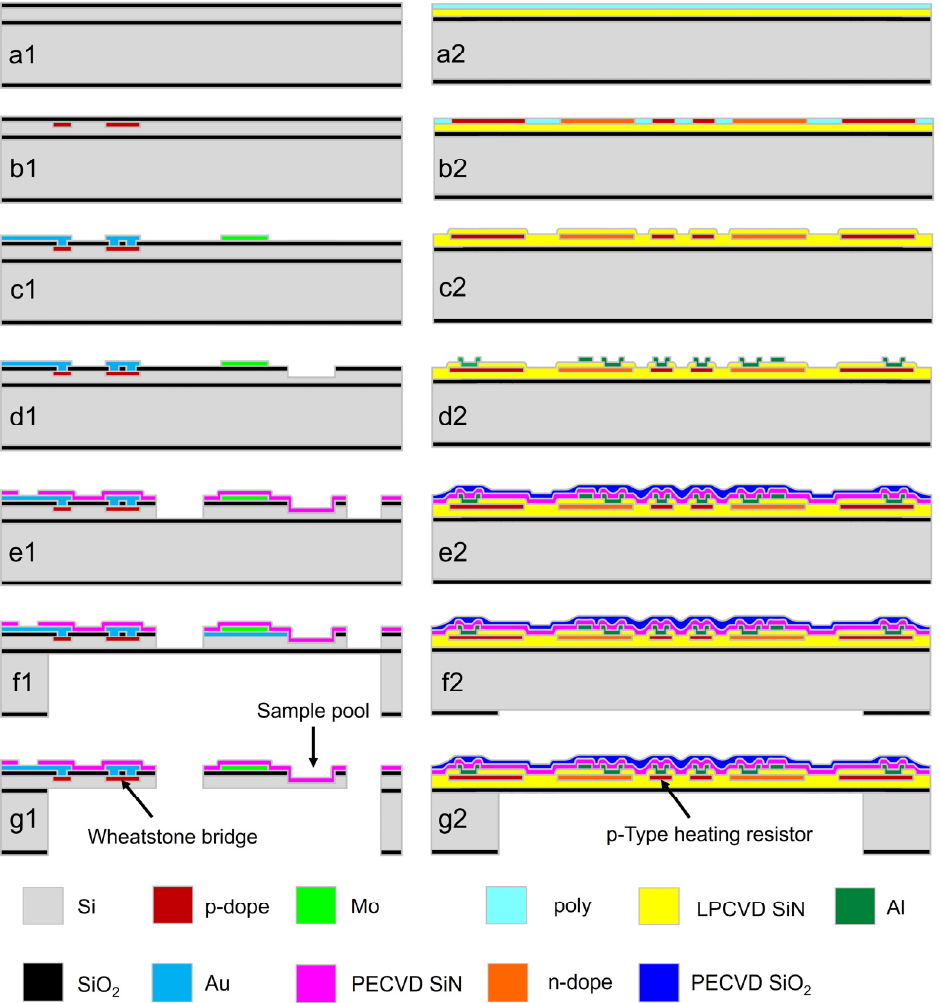
Figure 3. MEMS manufacturing process of the TG/DTA chips. The steps ( a1 – g1 ) are for the integrated resonant cantilever of MR-TGA chip and those from ( a2 – g2 ) are for the thermopile-integrated DTA chip. Figure 3a1: thermal oxidation is processed to (100) silicon-on-insulator (SOI) wafers, where the n -type active layer is 3 μ m in thickness. Figure 3b1: piezoresistive Wheatstone- bridge and electro–thermal resistor are simultaneously formed by using p -type silicon doping technique for frequency-signal readout and resonance excitation, respectively. Figure 3c1: 10 nm/200 nm Cr/Au composite layer is developed by using sputtering and patterned for interconnection. Then, 200 nm-thick Mo thin-film is sputtered and patterned into the heating resistor. Figure 3d1: the sample loading pool is formed by a shallow etch with reactive-ion-etch (RIE). Figure 3e1: 300 nm SiN is formed by using plasma enhanced chemical vapor deposition (PECVD) as passivation layer. After patterning, cantilever shape is patterned and formed with RIE. Figure 3f1: backside silicon etch using deep RIE is performed to remove the substrate silicon beneath the cantilever. Figure 3g1: structural release of the cantilever is processed by etching off the buried SiO 2 layer beneath the can- tilever with buffered aqueous HF. Figure 3a2: thermal oxidation is processed to the same (100) silicon wafer, which is then followed by low-pressure CVD (LPCVD) deposition of 300 nm low-stress SiN and 500 nm polysilicon. Figure 3b2: Boron and phosphorous ion implantation processes are sequentially implemented to form the n -type and p -type polysilicon microregions of the n / p polysilicon thermocouple and the p -type heating resistor. The resistance of n / p -poly is